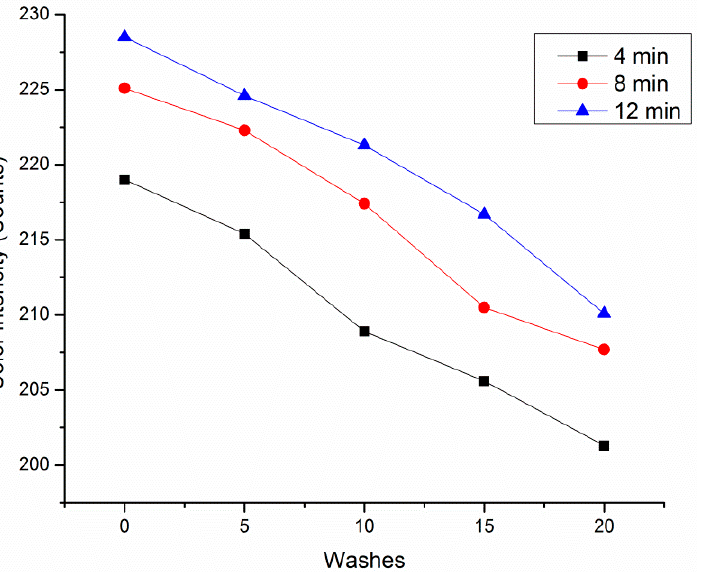
Figure 15. Washing durability and reusability of the ZnO-nanorod-coated fabric at different microwave irradiation times.